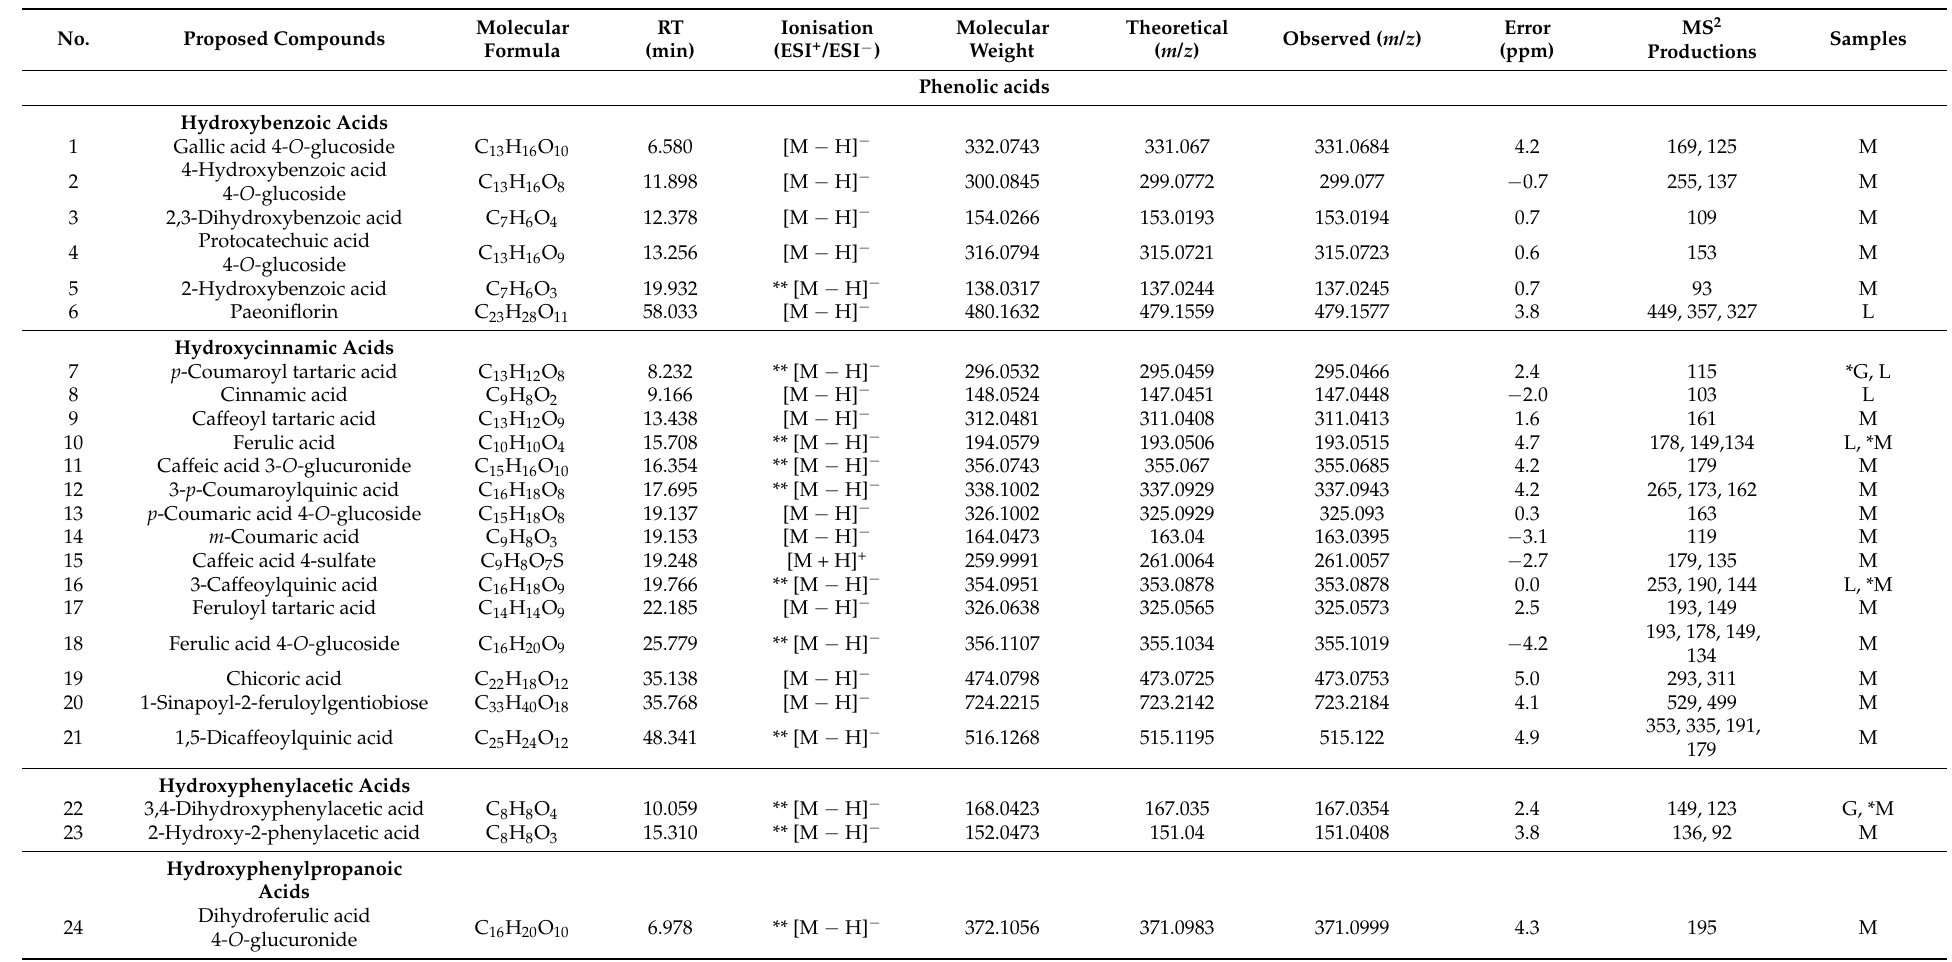
Table 3. LC-ESI-QTOF-MS/MS characterisation of phenolic compounds in ginger, lemon and mint